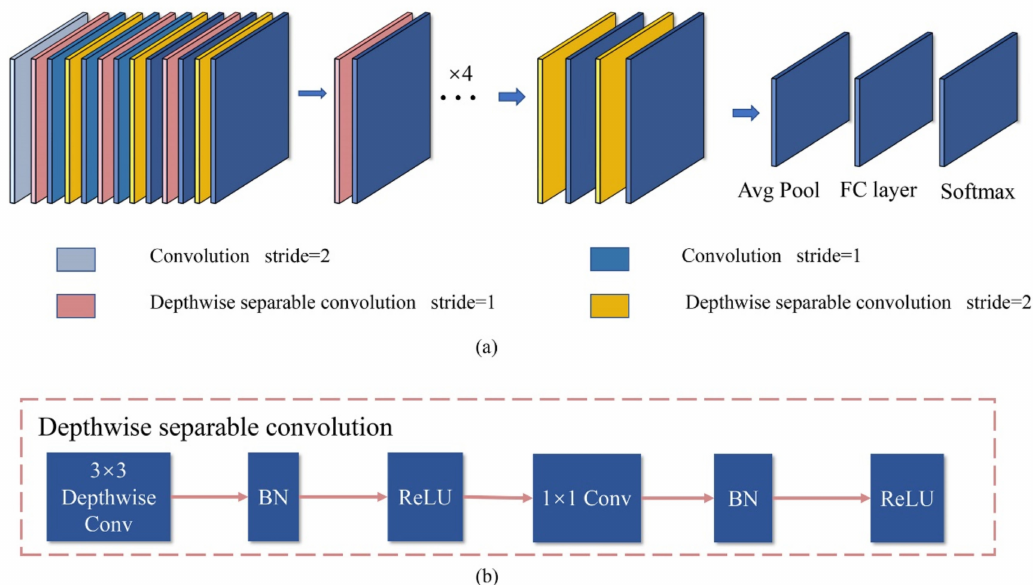
Figure 5. The structure of MobileNets and depthwise separable convolution. ( a ) The schematic architecture of MobileNets. ( b ) Depthwise separable convolution. “Avg Pool” denotes average pool, “FC layer” denotes fully connected layer, and “BN” denotes batch normalization. ReLU: rectified linear